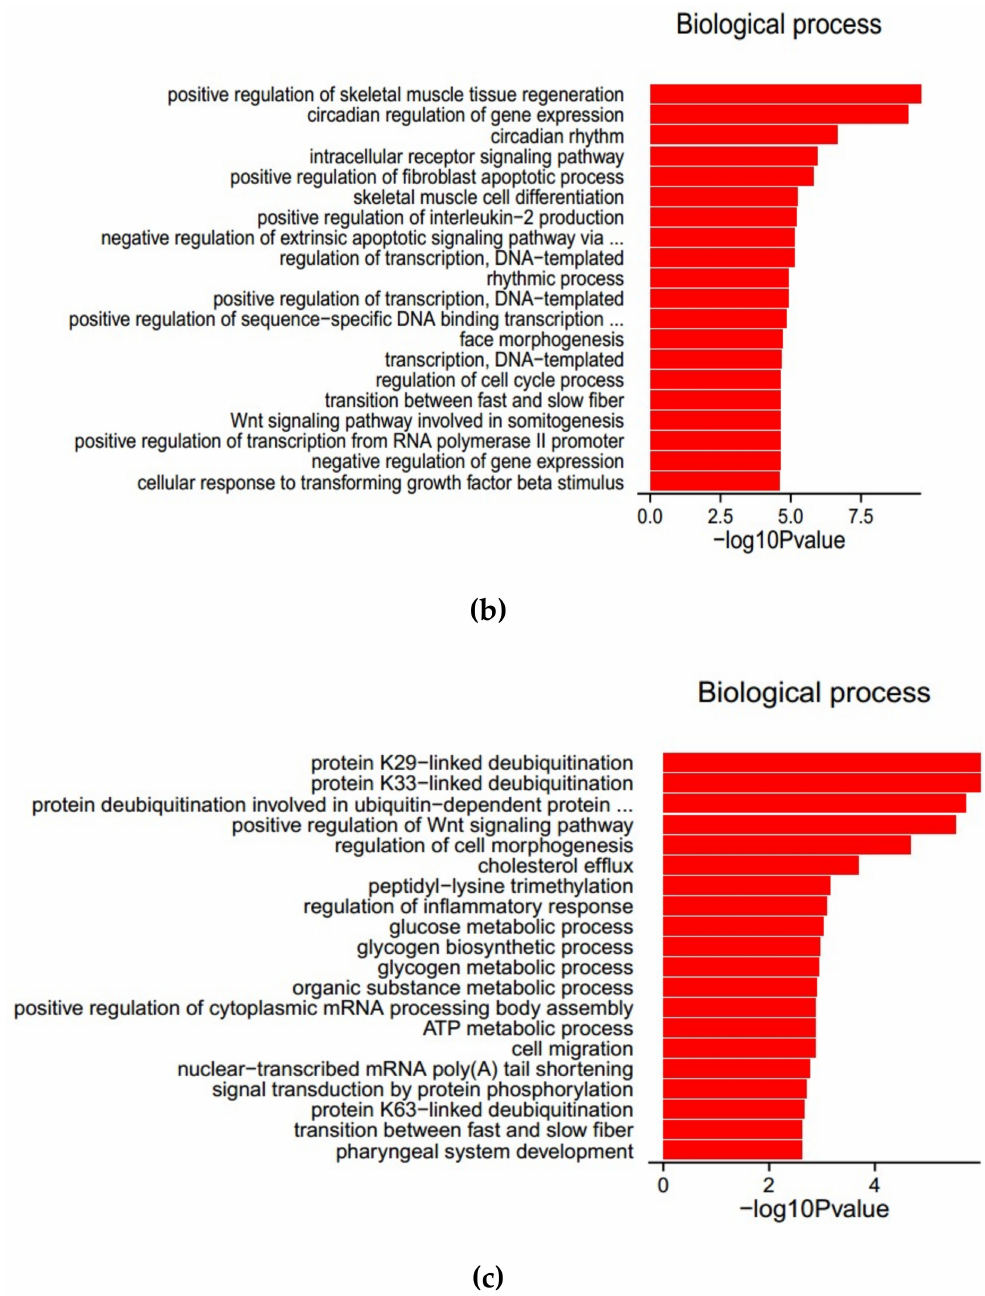
Figure 3. Functional analysis of genes (DEMs) and circRNAs (DECs) differentially expressed in Huainan (HN) and Duroc × (Landrace × Yorkshire) (DLY) pigs. ( a ). DEMs associated with muscle development and fatness (the outer ring represents 1 to 18 porcine autosomal and X, Y sex-chromosomes. The middle ring indicates the DEMs involved in muscle growth and development. The scatter plot in the inner ring represents genes present in the porcine muscle; the size of the solid circle stands for -log 10 ( p value); the red symbols represent genes that were up-regulated in HN pigs; the green represents down-regulated genes; and the blue represents equally expressed genes); ( b ). Enriched biological process of DEMs; ( c ). Enriched biological process of